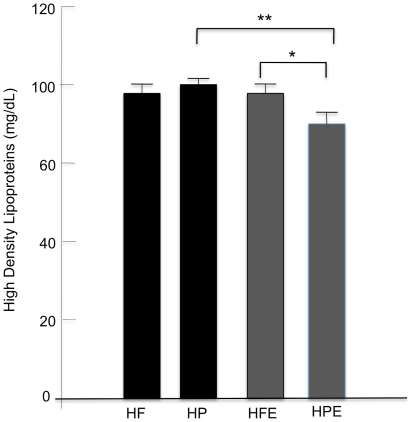
HDL profiles.HDL was measured in blood samples by gas chromatography as described for Figure 4; labeling and statistics also as described in Figures 3 and 4; *p<0.05; **p<0.001.